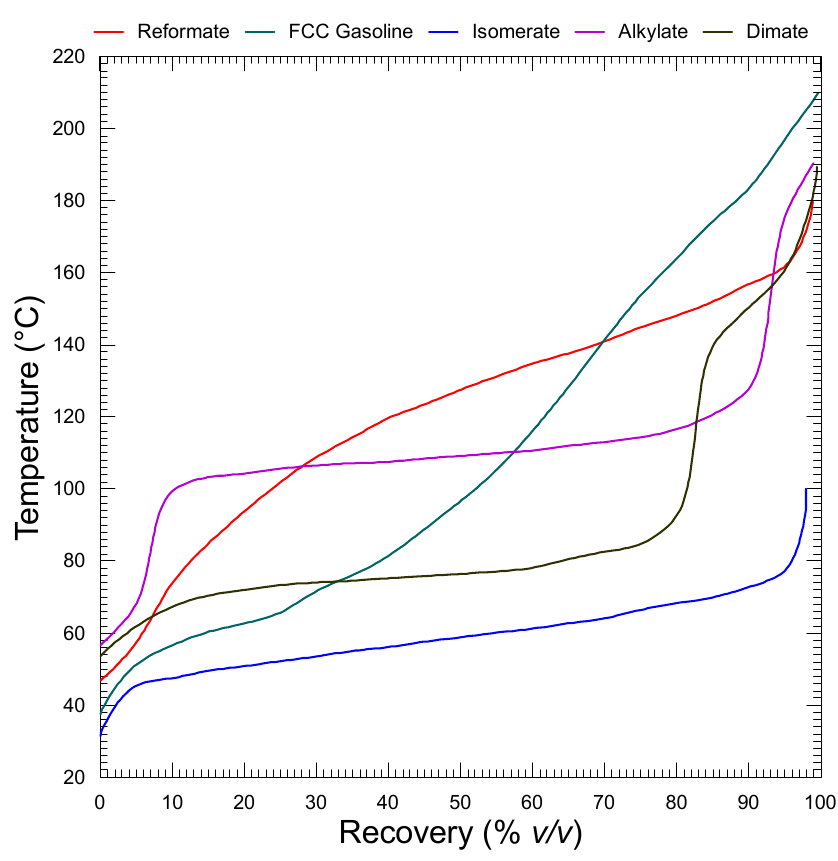
Figure 1. Distillation profiles of the refinery fractions used. Table 3. Properties and composition of base fuels.